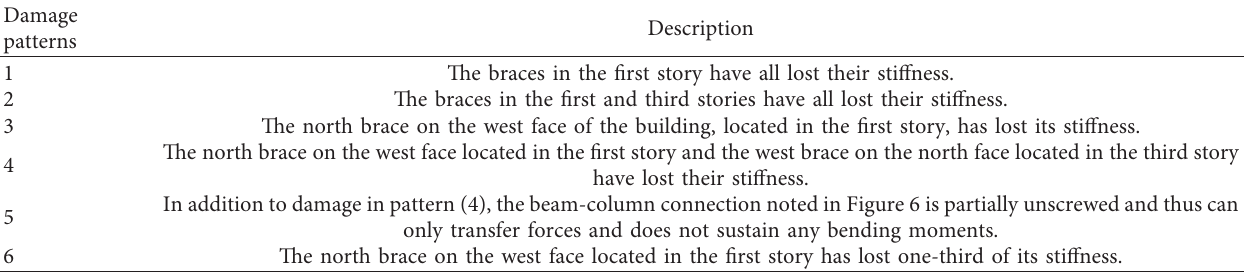
Table 1: Description of the damage patterns considered for IASC-ASCE benchmark structure [37]. Damage patterns